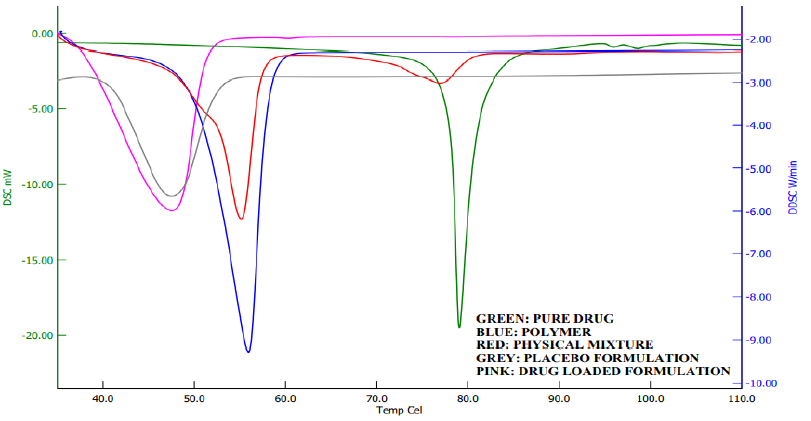
Figure 9. Differential scanning calorimetric curves of darunavir, Poloxamer, physical mixture, placebo, and in situ gel formulation (D7).